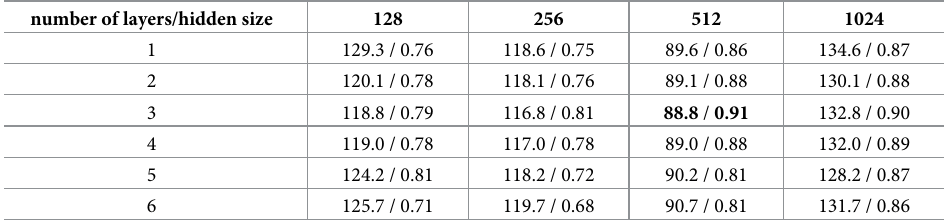
Table 6. PPL and BLEU scores for varying number of layers and hidden sizes on topical chat test frequent set.